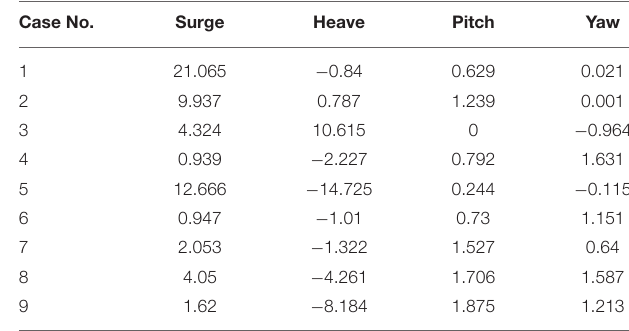
TABLE 3 | Test matrix. TABLE 4 | Error variation of FOWT platform motions